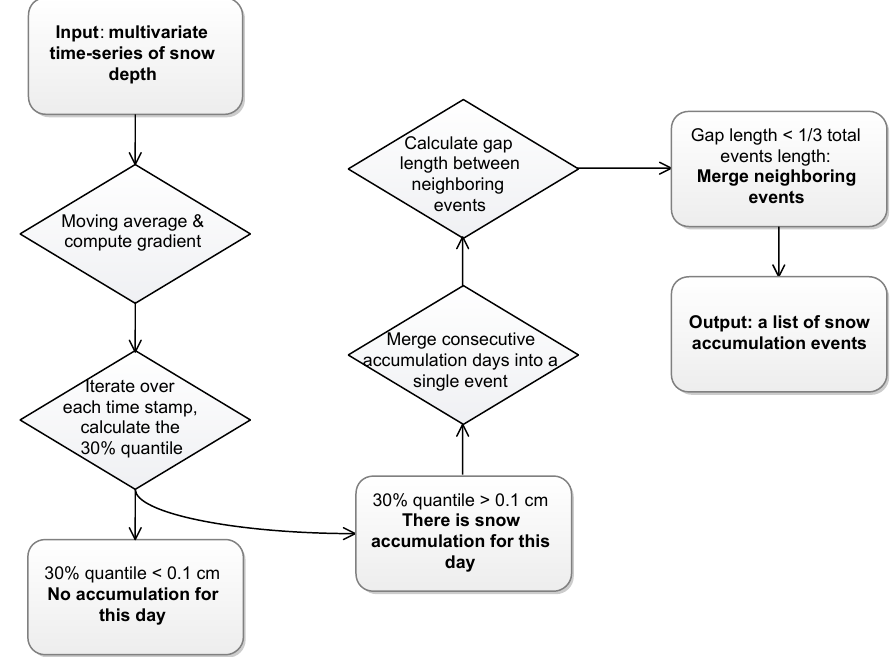
Figure 3. The block diagram of the snow accumulation detection